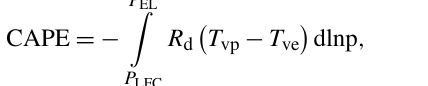
Figure 1. Trend (shading) of fine dust concentration (µgm − 3 ) from 1990 to 2015 in (a) DJF, (b) MAM, (c) JJA, and (d) SON from IMPROVE gridded data. Dotted areas are significant at the 95% confidence level. The colored circles show the trend at IMPROVE stations with consecutive records for at least 23 years during 1990– 2015. Circles with green outlines denote that the trend is significant at the 90% confidence level. Black boxes denote the averaging areas of the southwestern US (solid) and the Great Plains